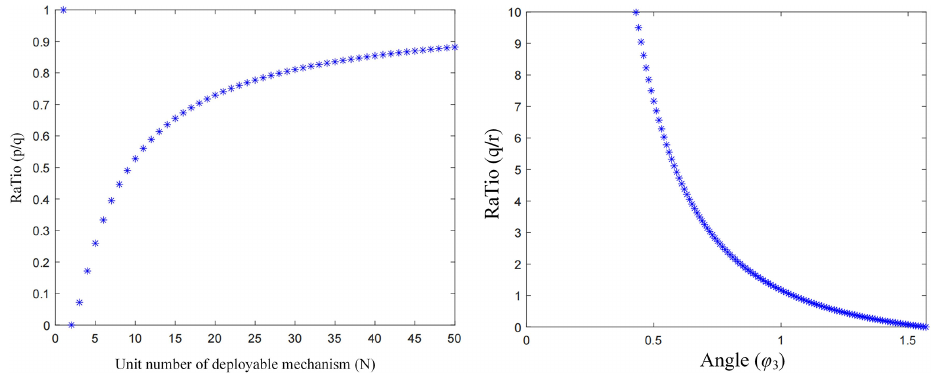
Figure 6. Two-dimensional diagram of the proportional scissor rod relationship.